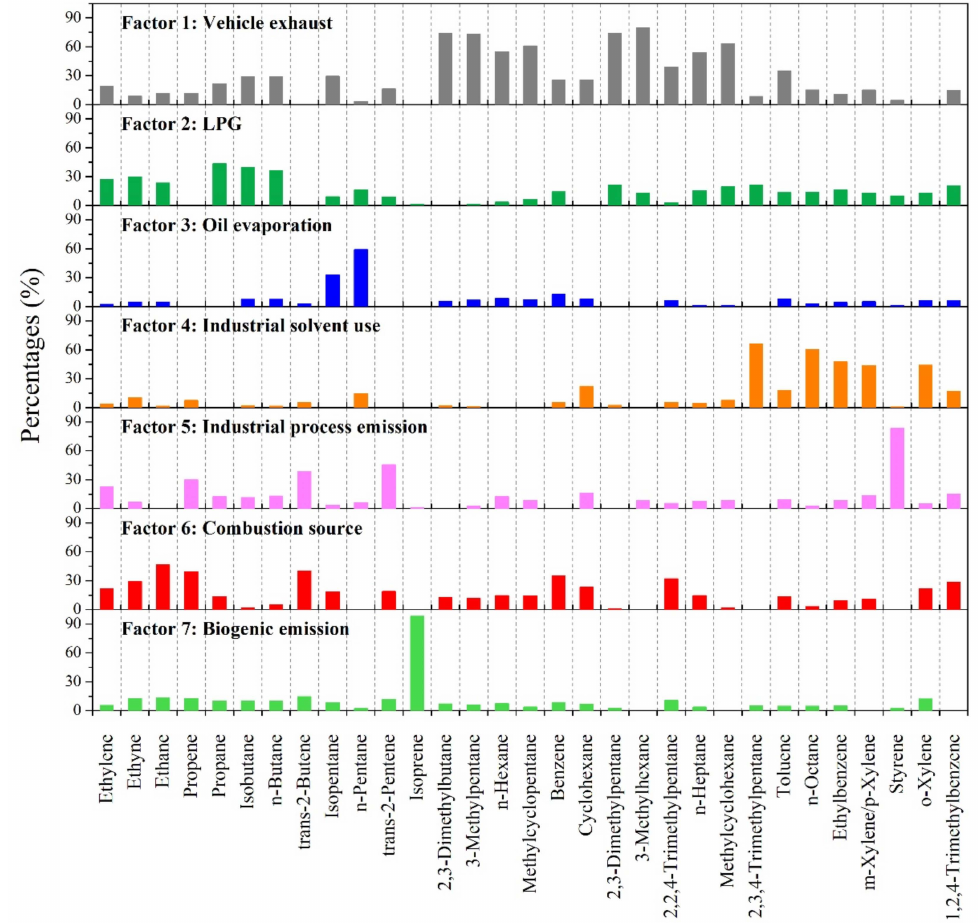
Figure 7. Source profiles of VOCs resolved from